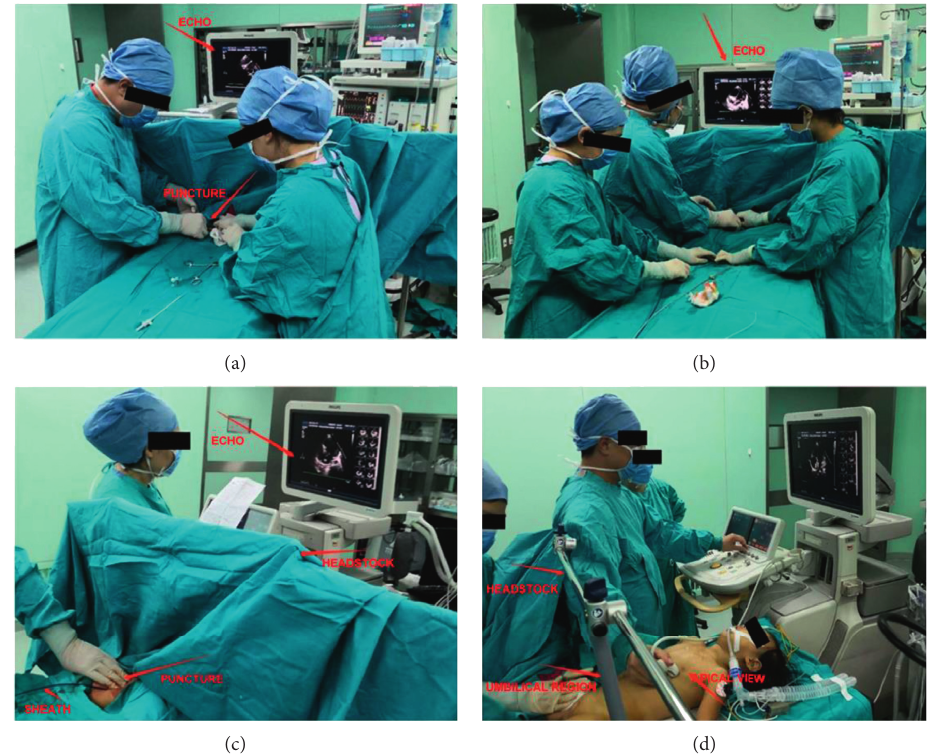
Figure 2: Percutaneous device closure of pediatric atrial septal defect through the femoral vein guided by transthoracic echocardiography without radiation: (a) in the operating room without radiological equipment, right femoral vein puncture point; (b, c) procedure under the guidance of transthoracic ultrasound; (d) the headstock (red arrow) and the child’s umbilical region (red arrow) are vertically parallel, which can help isolate the surgical area and the ultrasound area.